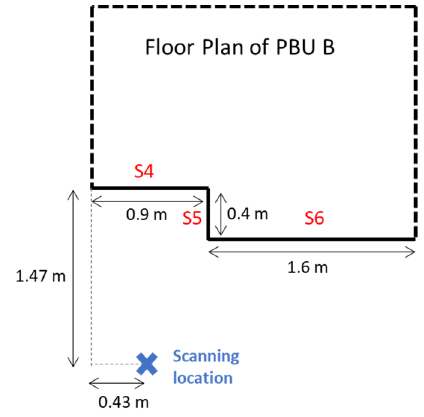
Figure 21. Optimal scanning location for PBU B obtained from simulations.